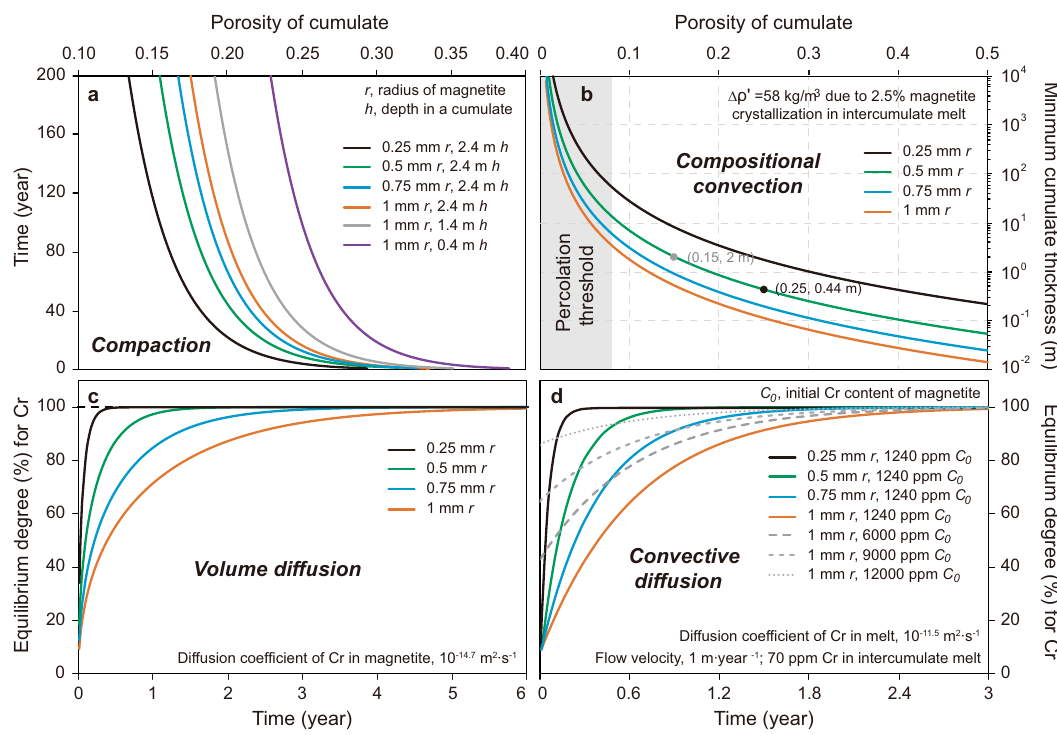
Fig. 2 Model calculations of compaction and reactive transport in magnetite mush. Modeling results for a variation of magnetite mush porosity with time due to compaction. b Minimum thickness allowing compositional convection for mushes with indicated porosities. More thoroughly compacted lower portions of the mush may not spontaneously initiate compositional convection whereas more open upper portions could ( Δ ρ ′ is density difference between interstitial melt and overlying melt in the main magma body). c Approach of the bulk composition of magnetite grains (integrated over the entire diffusion pro fi le) during volume diffusion of Cr due to re-equilibration of magnetite with migrating intercumulus melt. d Approach of bulk composition to equilibrium via convective diffusion for various sizes and initial Cr contents C 0 of magnetite. Colored lines are for crystal sizes as in a , c , and dashed lines represent magnetite grains with different initial Cr contents. Time scales of diffusive re-equilibration are much shorter than the time scale of compaction, supporting the assumption of instantaneous magnetite-melt equilibrium in the percolation